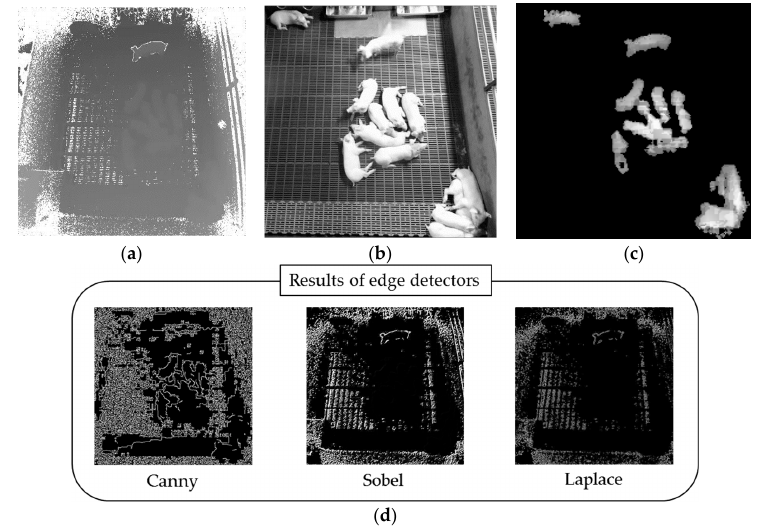
Figure 2. Difficulty of separating touching-pigs: ( a ) depth image; ( b ) gray image converted from a corresponding color image (during daytime); ( c ) result of contrast limited adaptive histogram equalization (CLAHE) [29] after background subtraction; ( d ) results of the edge detectors [30].